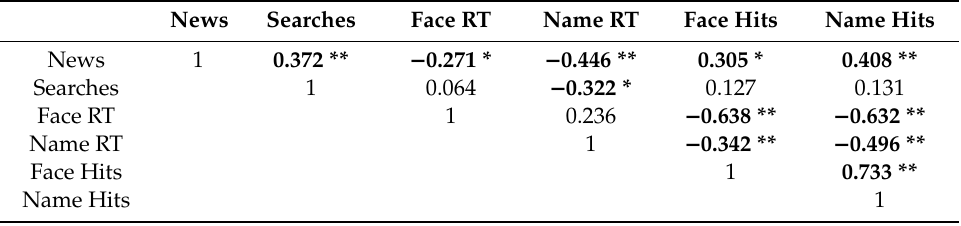
Table 2. Pearson correlation coe ffi cient among the variables of interest in Experiment